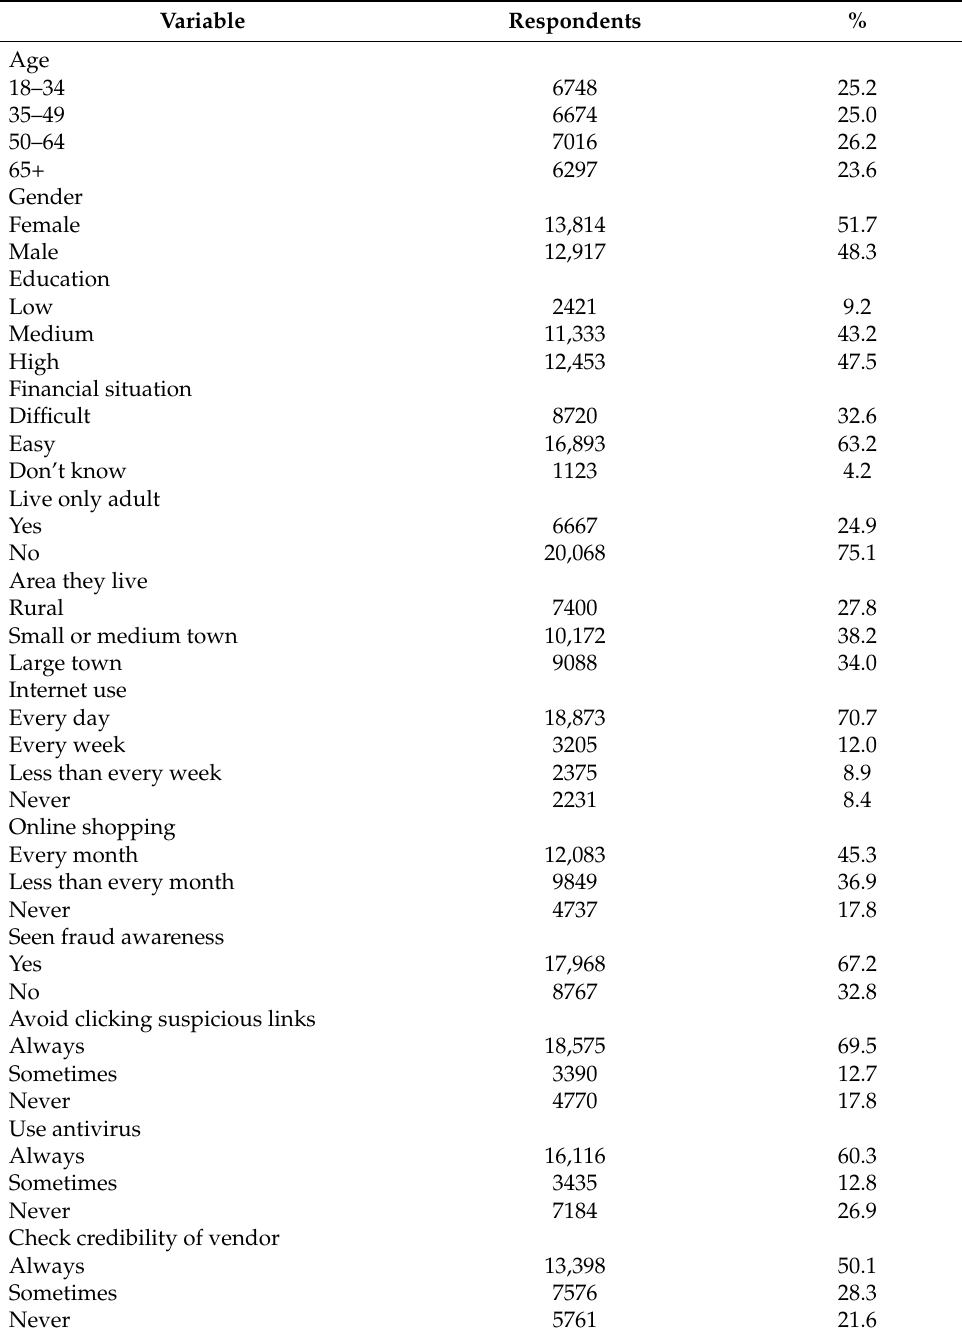
Table 1. Predictor variables in weighted